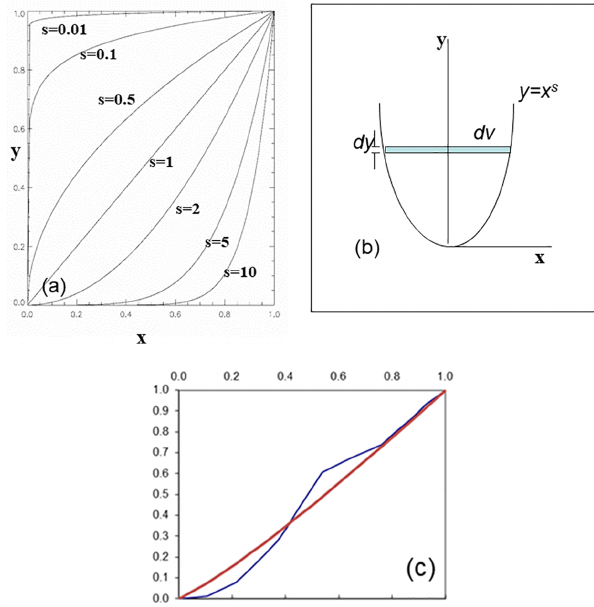
Figure 4. (a) Theoretical “hypsographs” for idealized axially sym- metric lakes with different shape factors s indicated; (b) schematic to aid in determining the volume of an axially symmetric lake; (c) normalized observed hypsograph (blue) and theoretical estimate (red) for L239. See text for